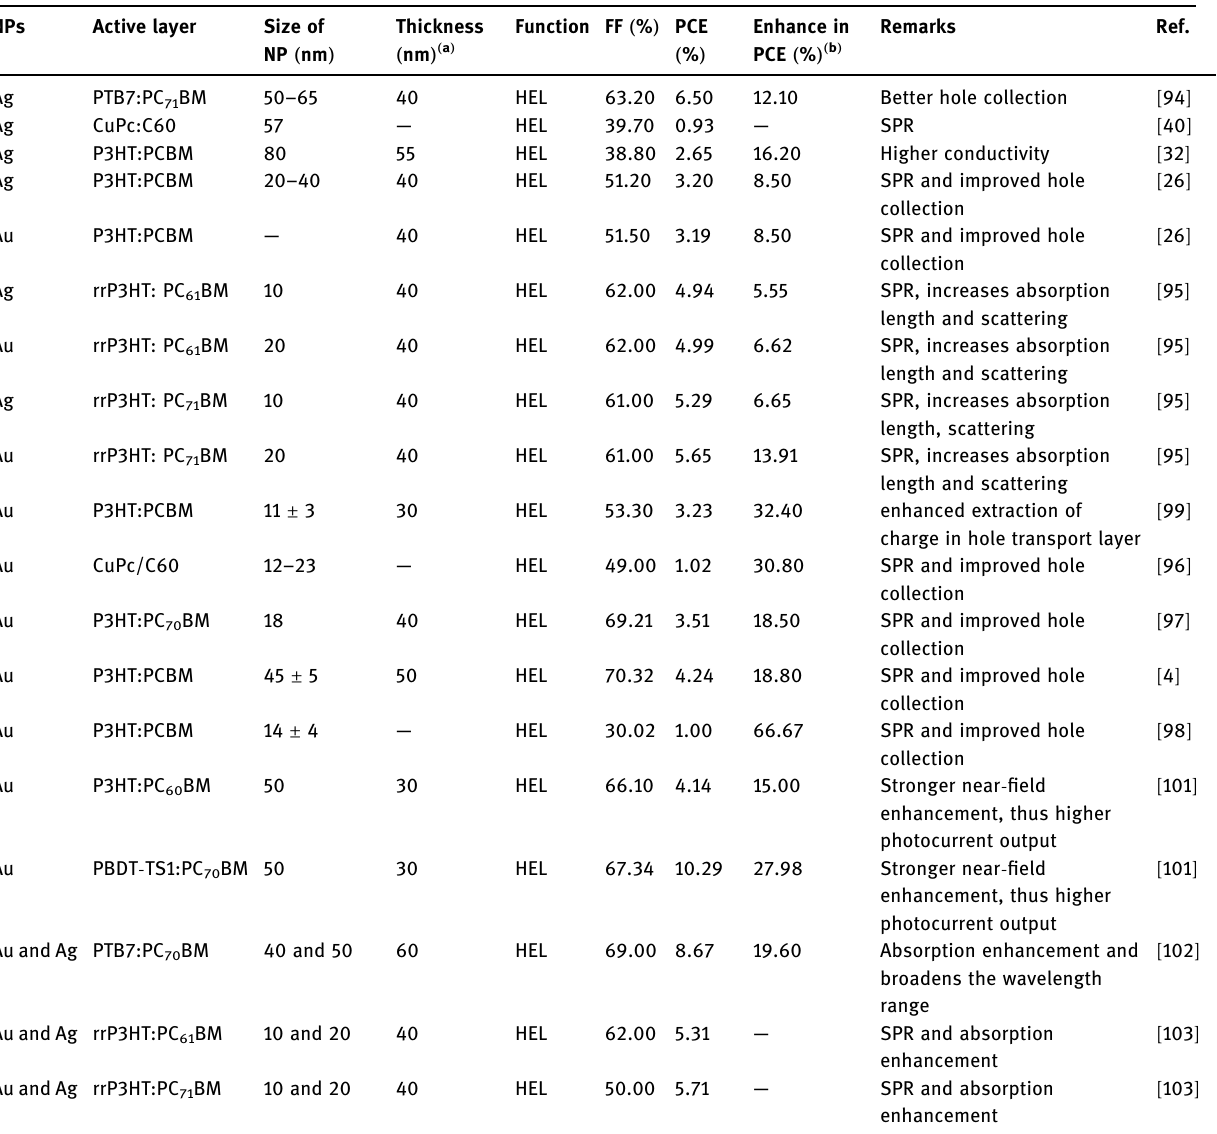
FF: fi eld factor, PCE: power conversion e ffi ciency, HEL: hole extraction layer, ( — ) : no data provided. ( a ) : thickness of PEDOT:PSS:NPs composite layer, ( b ) : compared with pristine